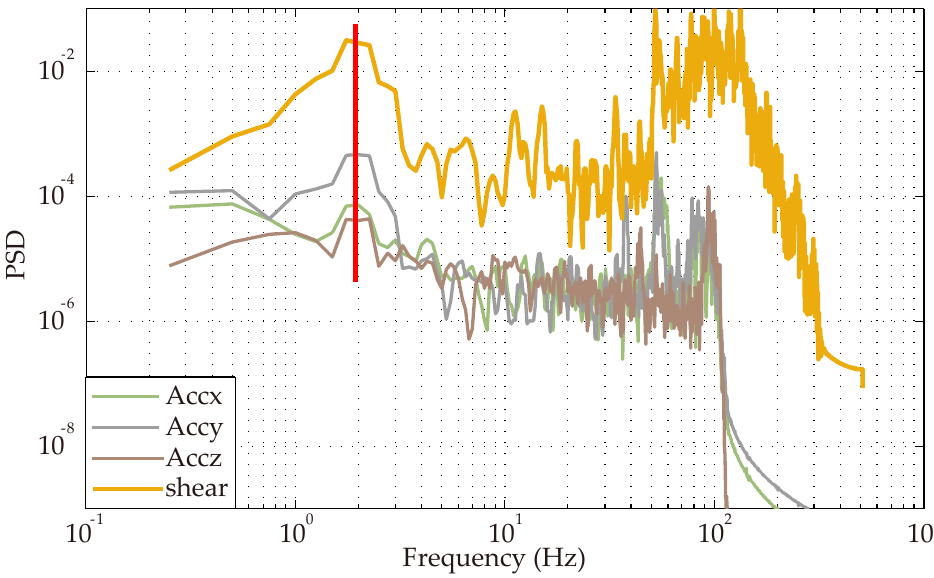
Figure 6. Frequency spectrum of the collected shear and accelerations.